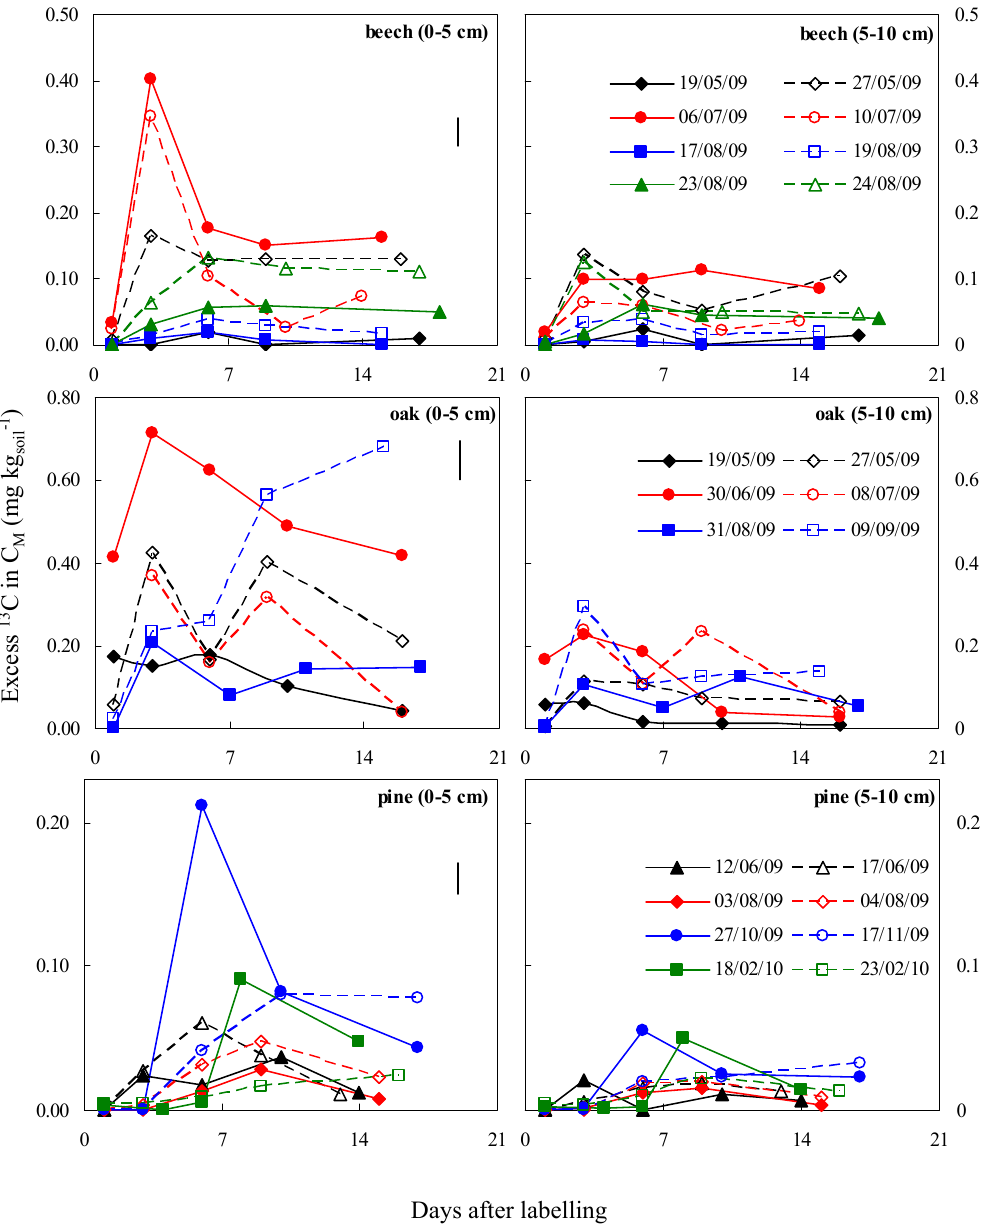
Fig. 5. Time courses of Excess 13 C in microbial carbon (C M ) after whole crown pulse labelling of beeches (top), oaks (middle) and pines (bottom) at 0–5cm depth (left) and 5–10cm depth (right). Data for 10–20cm depth in beech and pine are not shown but they are included in the statistical analyses. Each tree is identified by its date of labelling. There are significant differences between trees ( F 7 , 120 = 22 . 0, F 5 , 23 = 10 . 1 and F 7 , 120 = 3 . 8, for beech, oak and pine respectively, p < 0 . 001), between depth ( F 2 , 120 = 22 . 0, F 1 , 23 = 47 . 1 and F 2 , 120 = 14 . 5 for beech, oak and pine respectively, p < 0 . 001) and between sampling dates ( F 96 , 120 = 2 . 5 for beech, p < 0 . 001, F 23 , 23 = 2 . 4 for oak, p < 0 . 05 and F 96 , 120 = 3 . 0 for pine, p < 0 . 001). The verticals bars represent the root mean error. Data are presented on two different panels according to depth but depth was included in the